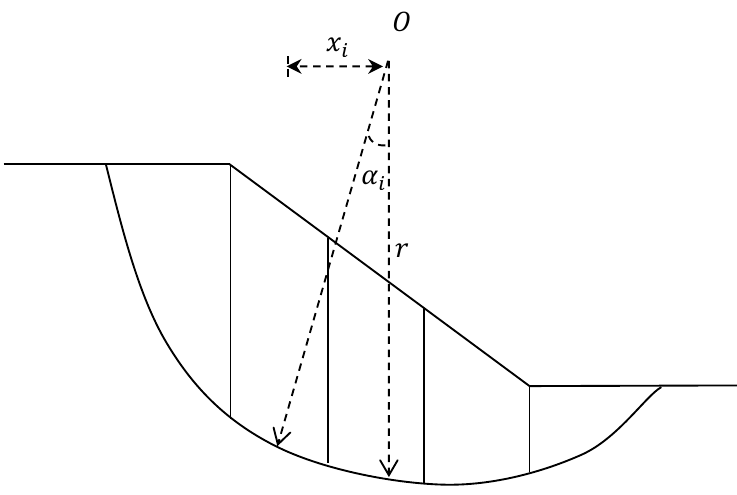
Figure 1. Sliding circular surface subdivided into vertical